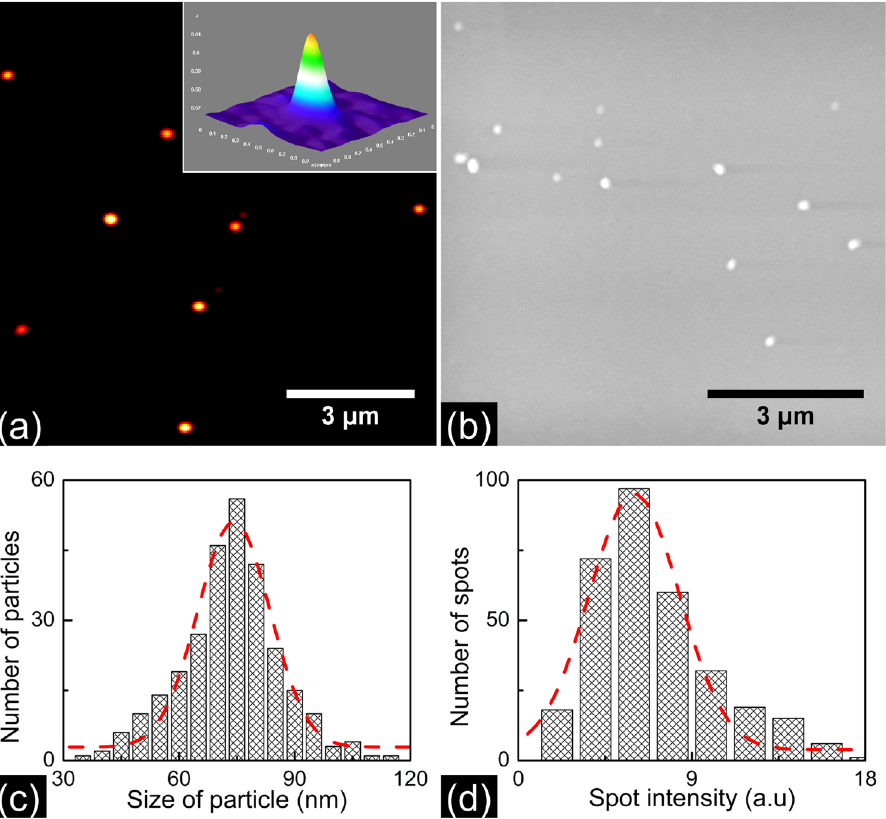
Figure 1. ( a ) Two-photon photothermal image of the 70 nm BaTiO 3 nanoparticles spin coated on a coverslip at 4000 rpm for 30 s. The images are taken with 6 mW pump power and 0.8 mW probe power at the sample. The inset shows the pseudo 3D image of single BaTiO 3 corresponding to the thermal profile generated. The SNR in the images shown is 47 ( b ) Scanning electron microscopy image of BaTiO 3 having an average size of 70 nm prepared same as above. The figure shows single isolated BaTiO 3 nanoparticles on the coverslip. ( c ) Particle size distribution histogram of BaTiO 3 nanoparticle measured from the SEM images. The dotted line shows a Gaussian curve fit and the average particle size is found to be 70 nm and size distribution is (13 ± 2)%. ( d ) Two- photon photothermal intensity distribution histogram of BaTiO 3 nanoparticles. The percentage distribution in intensity is (41 ± 5)%. Since the two-photon photothermal intensity scale with volume of the particle the intensity distribution is expected to be three times that of the particle size